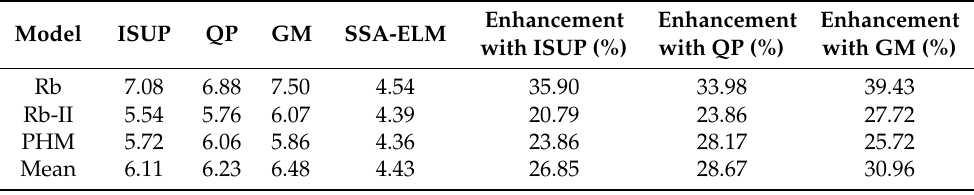
Table 10. The average RMS values of 6 days for three different prediction models (ns).